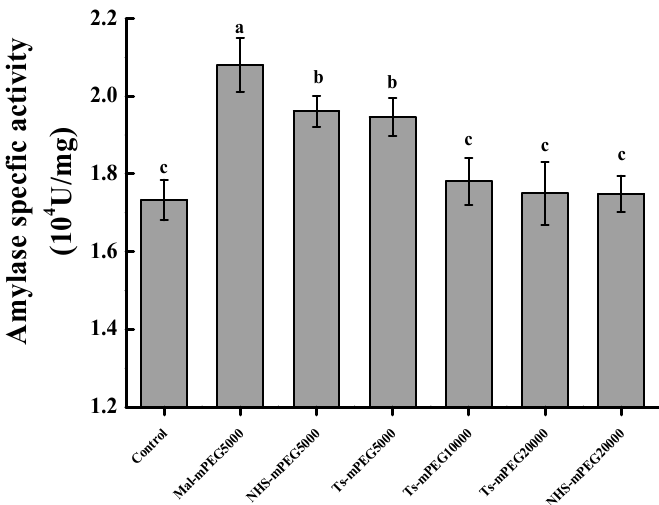
Figure 1. Effect of 6 types of modifiers on SPA activity. Significant difference in each column are expressed as different superscript letters ( p < 0.05).